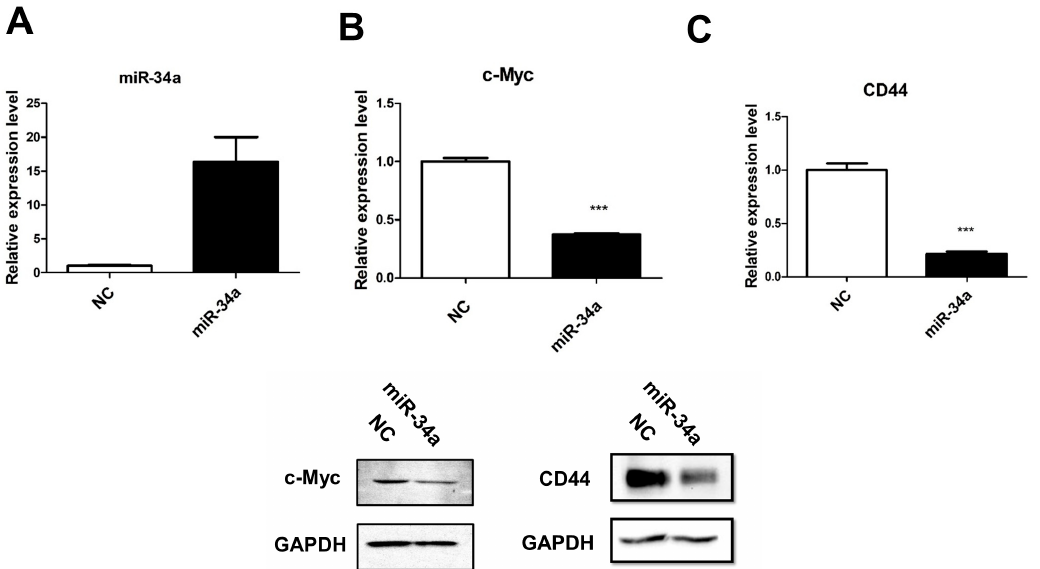
Figure 2. miR-34a targets both c-Myc and CD44 , in UMUC3 urothelial cancer cells. ( A ) Expression of mature miR-34a in UMUC3 cells overexpressing pri- miR-34a or an empty vector (NC). Overexpression of miR-34a led to the downregulation of ( B ) c-Myc and ( C ) CD44. Upper panel, RT-PCR; lower panel, western blot analysis. GAPDH was used as a loading control for western blot analysis. (*** p < 0.001).